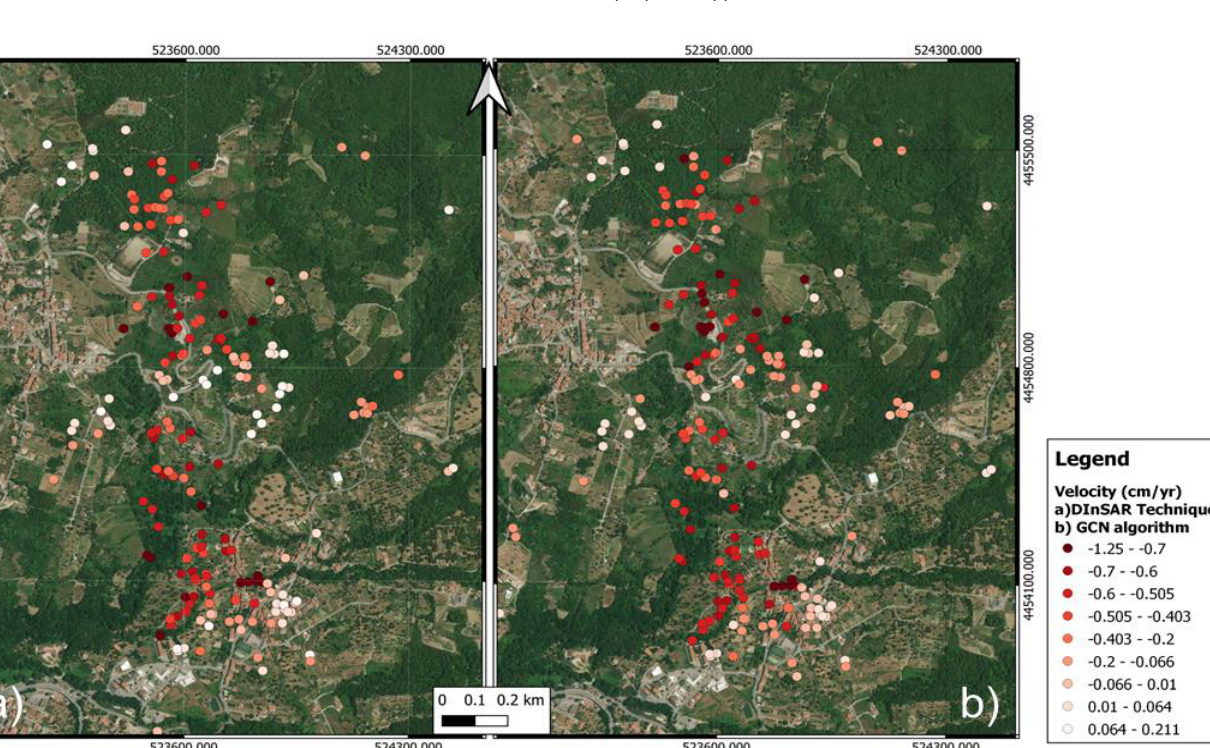
Table 2 . Evaluation metrics for the proposed approach